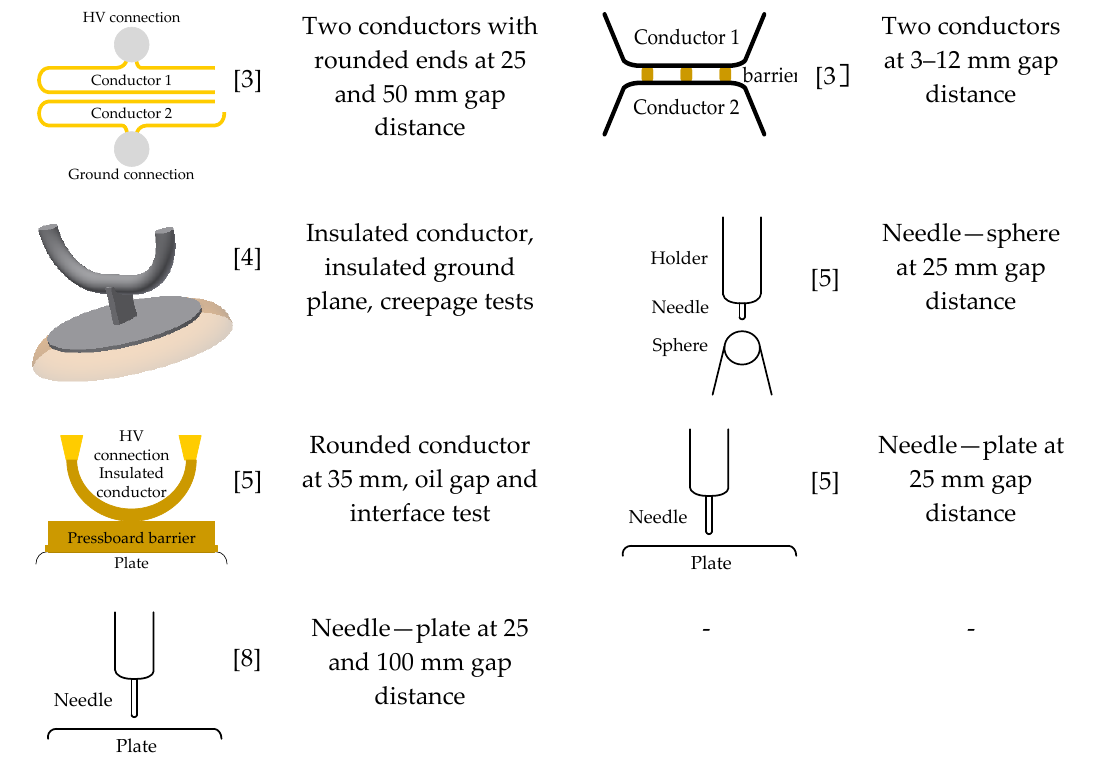
Figure 9. Different test arrangements for impulse testing of natural ester liquid compared to mineral oil.